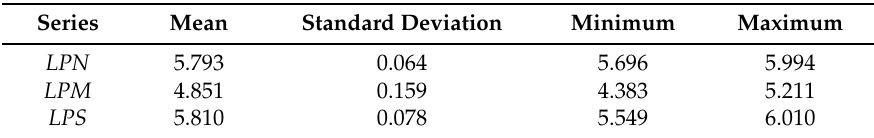
Table 2. Descriptive statistics of spruce and pine sawlogs.